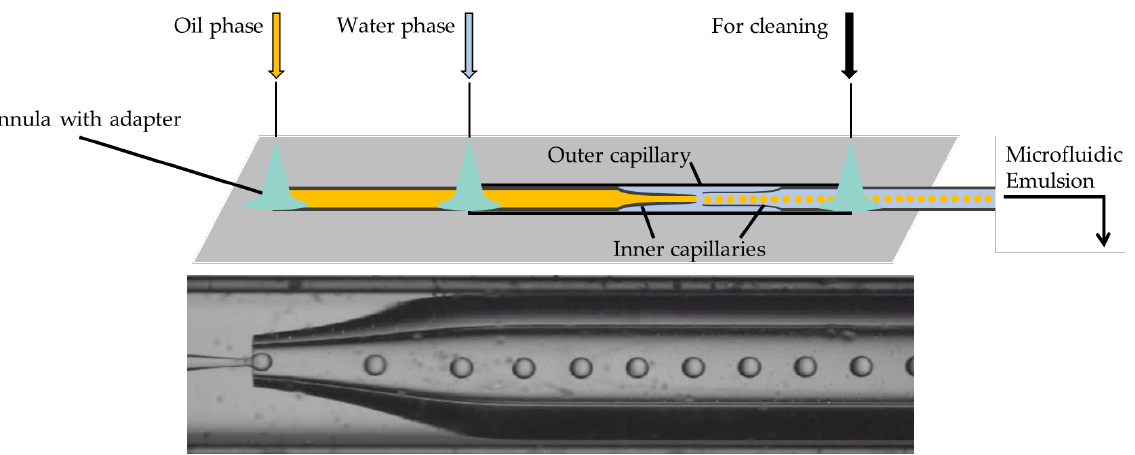
Figure 2. Draft ( a ) and micrograph ( b ) of the used microfluidic chip. The three cannulas are connected to syringe pumps, controlling the flow-rates. The left and right capillary have a diameter of 45 µm and 310 µm, respectively.